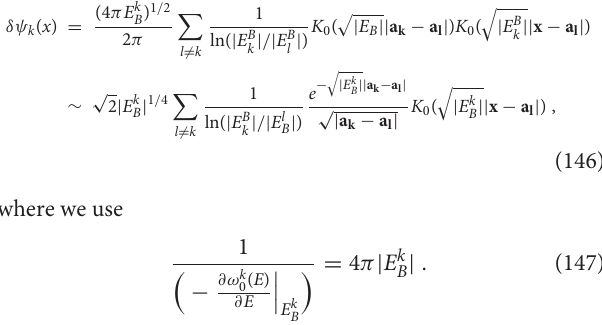
1 unit in three dimensions. =